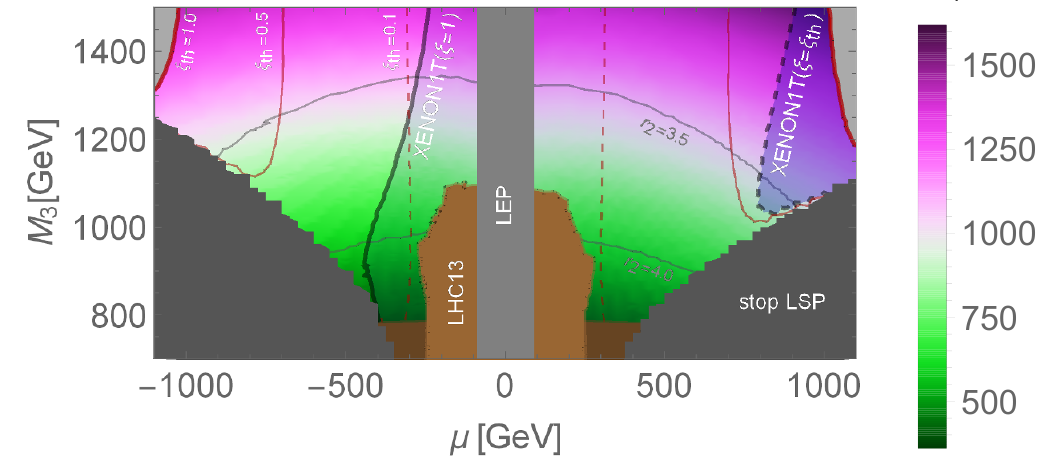
Figure 5 . Values of the dark matter observables with M 1 = 5 : 0 TeV. Meanings of lines and regions are same as in (cid:12)gures